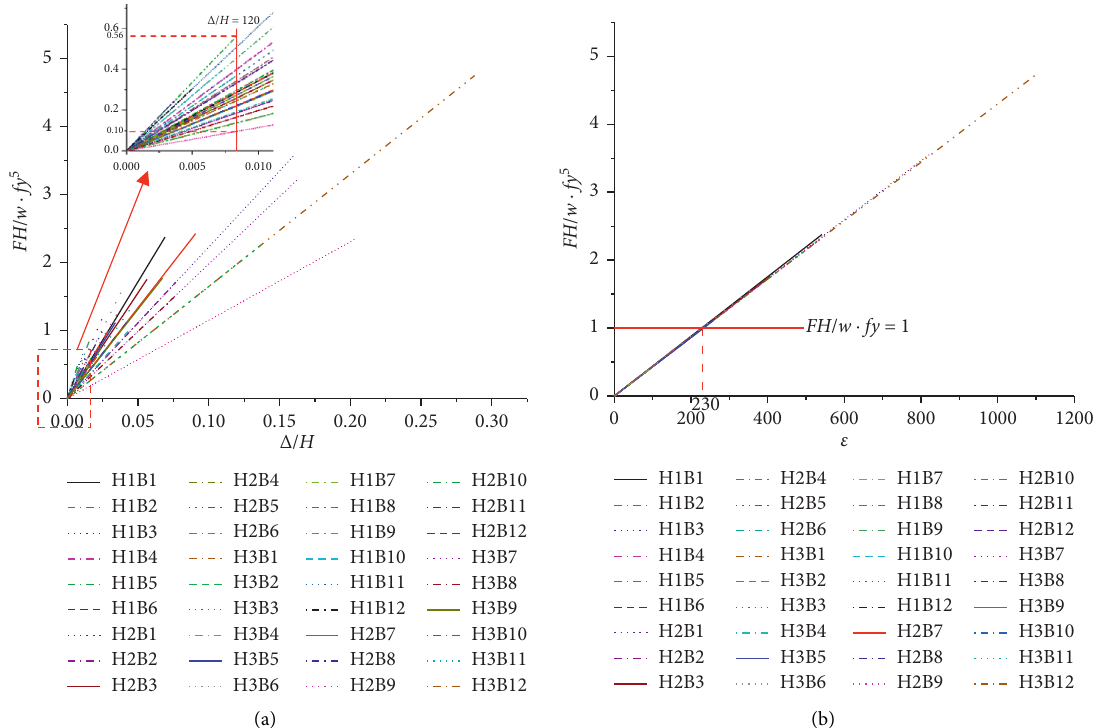
Figure 9: (a) Correlation curve (numerically calculated results) of FH / W · fy ∝ Δ / H . (b) Correlation curve (numerically calculated results) of FH / W · fy ∝ ε .